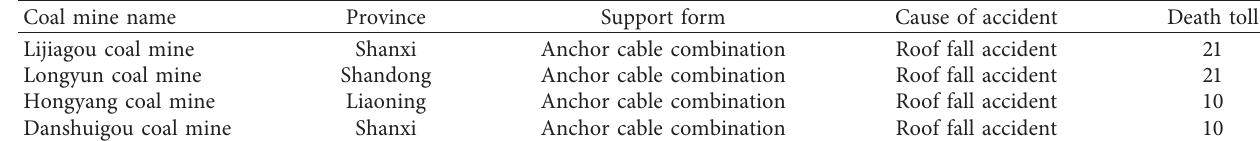
Table 1: Part of roof accident in coal mine in China from 2017 to